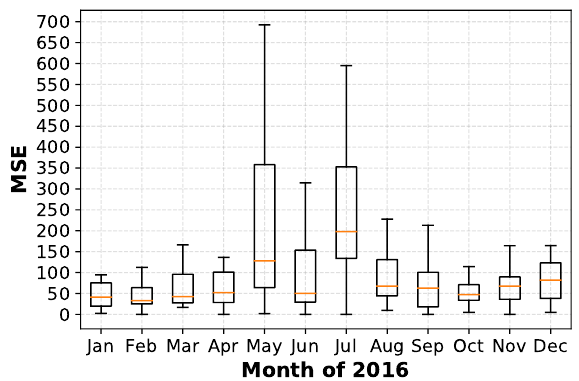
Figure 16. MSE performance of the three-layer ANN model for the entire year of 2016 aggregated by month.